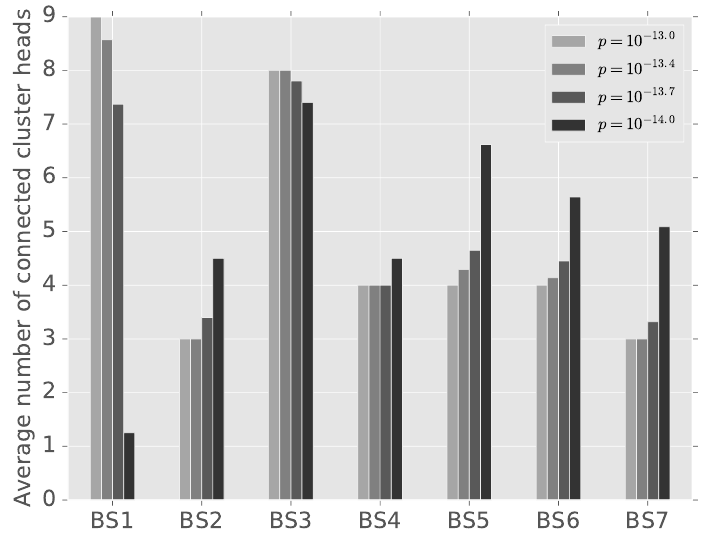
Figure 6. Average number of cluster heads connected to each base station with different power